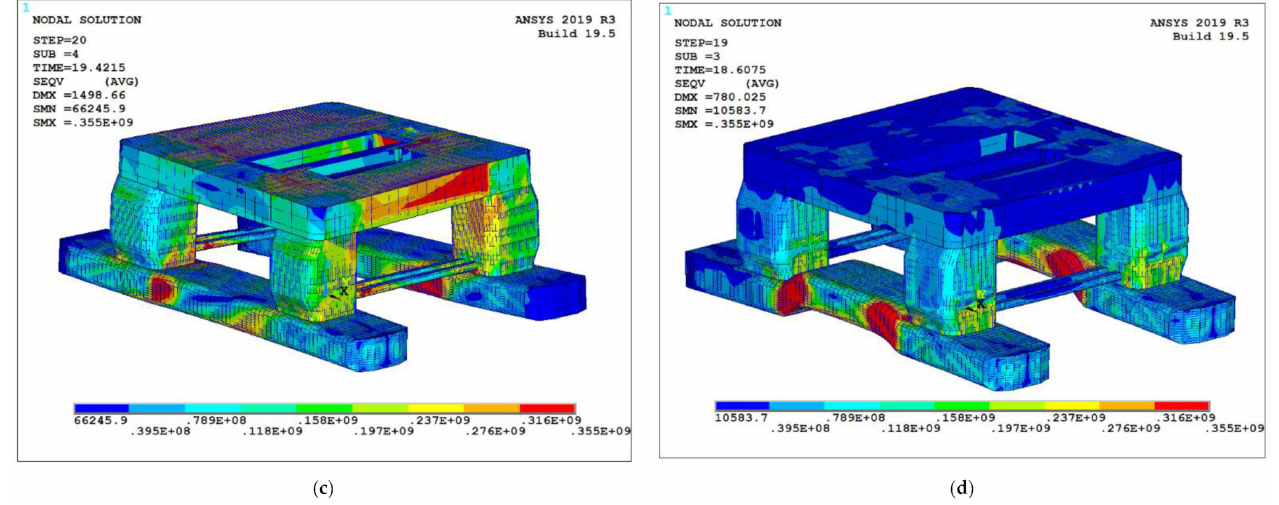
Figure 11. The ultimate limit states of the selected platform. ( a ) ULS of split force; ( b ) ULS of torsion moment; ( c ) ULS of shear force; ( d ) ULS of bending moment.